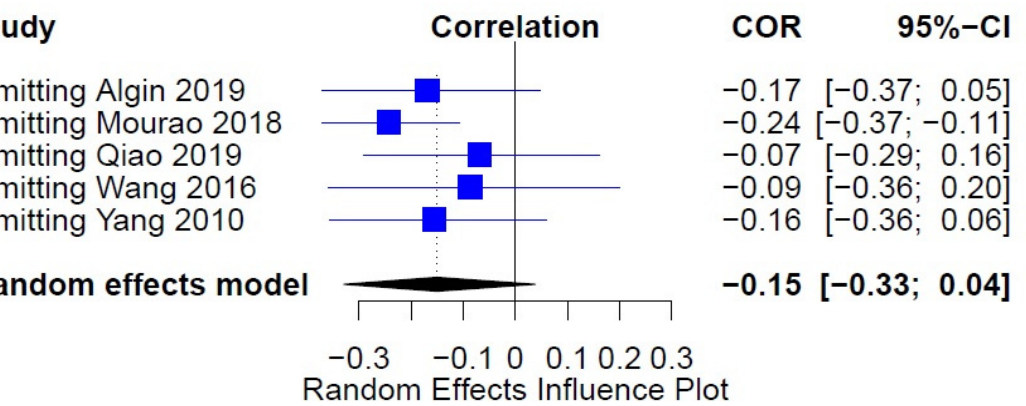
Figure 5. Serum BDNF and infarct stroke volume up. forest and down. funnel plot.